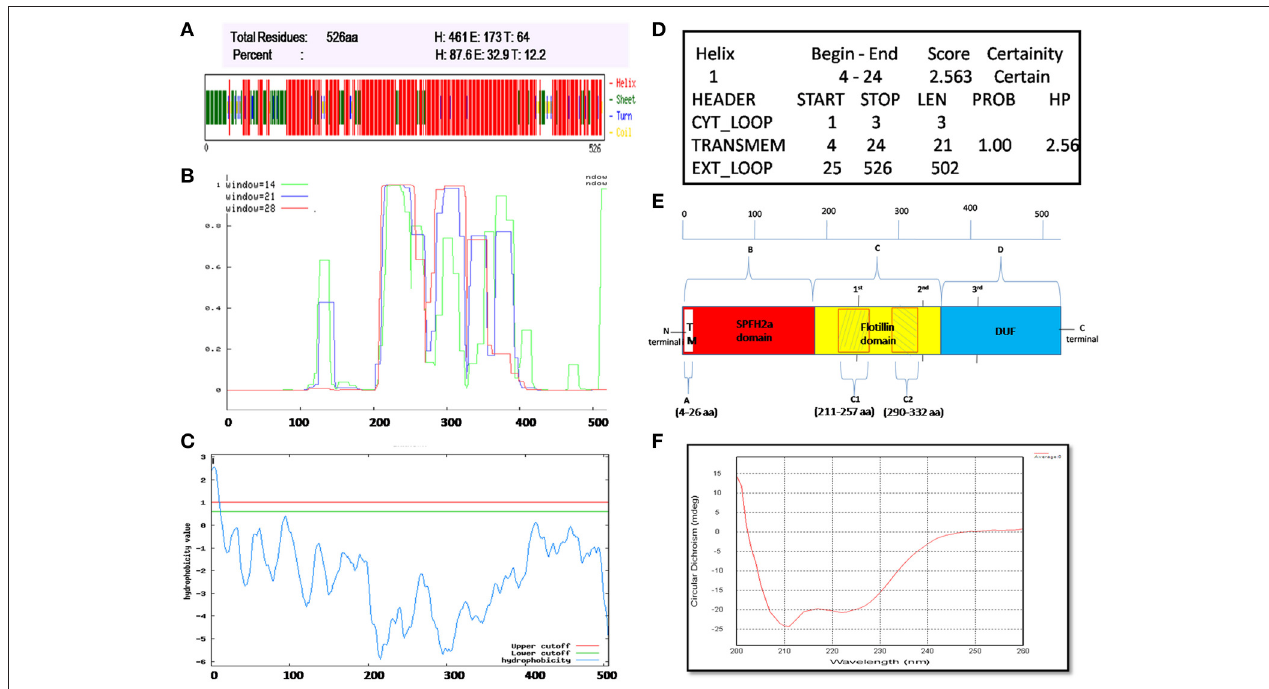
FIGURE 3 | Prediction and validation of FlotP Topology and Secondary structure. (A) Secondary structure by CFSSP server showing high percentage of α -helical structure (H-Helix; E-Sheet; T-Turns). (B) Prediction of coiled-coil region by Coils server with each size of aa windows. (C) Analysis of hydrophobicity index value by TopPred server predicting the presence of transmembrane region. Y-axis of the graph represents hydrophobicity value predicting the possible location of the particular amino acid stretch of the protein. Value > 1 indicate cytoplasmic fragment; 0–1, transmembrane; < 0, membrane. (D) Prediction of various sub regions by TopPred with their sub-cellular locations. (E) Schematic representation depicting secondary structure and topology of FlotP. Region A in white color represents transmembrane (TM) region (aa 4–26), region B in red color represents SPFH2a domain- characteristic of prokaryotic Flotillin (aa 34–203), region C in yellow color indicates Flotillin or oligomerization domain (aa 203–365) and region D in blue shows domain with unknown function (DUF; aa 365–495). The two shaded boxes (C1- aa 211–257 and C2- aa 290–332) in yellow region C shows two high probability regions of coiled coil or trimer/dimer or interaction. Characteristic 1st, 2nd, and 3rd AEAE repeats are indicated at positions aa 335, 245, and 405. (F) CD spectra of purified rFlotP protein showing absolute probability of α -helix secondary